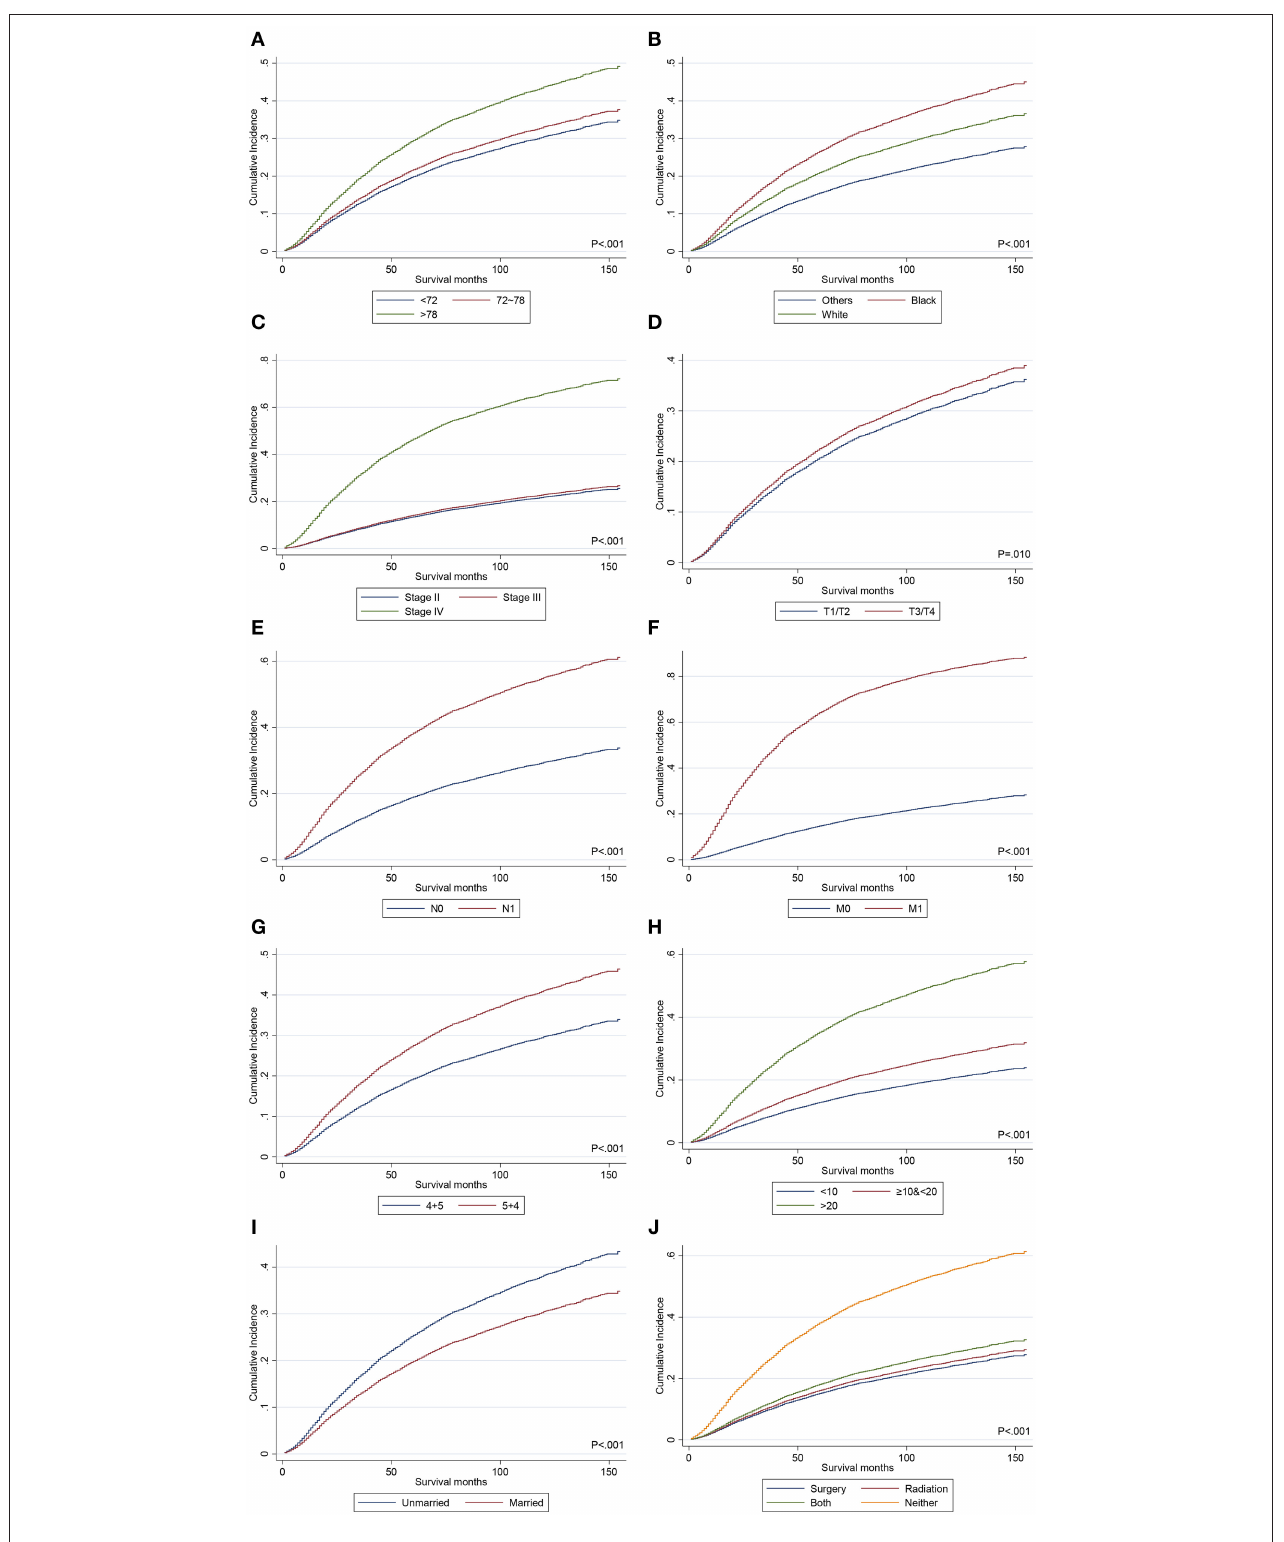
FIGURE 4 | The CIF curves of CSM before PSM. (A) CIF curves for age at diagnosis; (B) CIF curves for race; (C) CIF curves for AJCC stage; (D) CIF curves for AJCC T stage; (E) CIF curves for AJCC N stage; (F) CIF curves for AJCC M stage; (G) CIF curves for Gleason patterns; (H) CIF curves for PSA levels; (I) CIF curves for marital status; (J) CIF curves for treatments. CIF, cumulative incidence function; CSM, cancer-specific mortality; PSM, propensity score-matching; PSA, prostate-specific antigen.